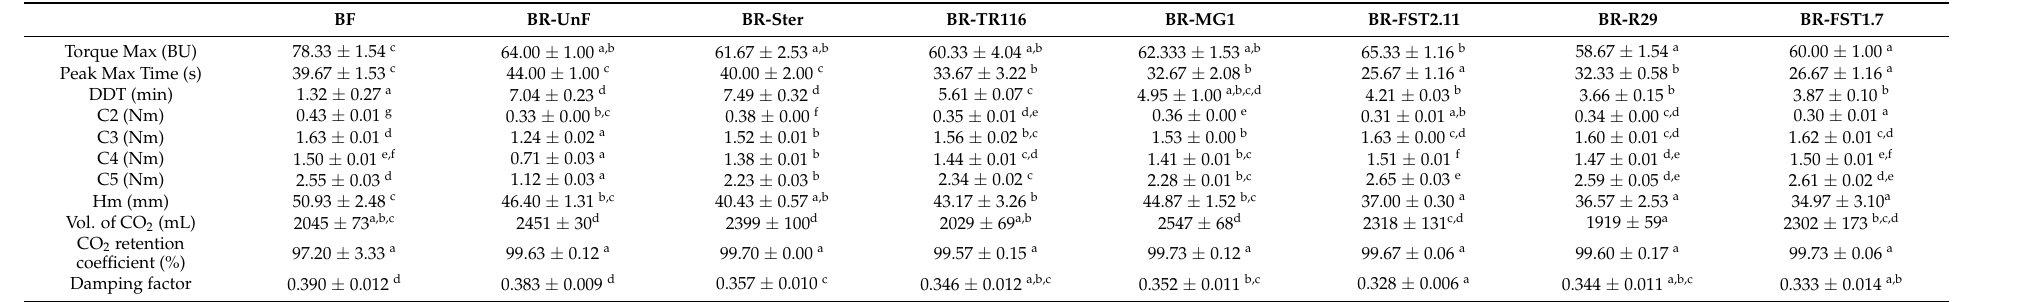
Table 4. Dough characteristics with BR inclusion. BF, BR-UnF, and BR-Ster represent control recipes using baker’s flour, 5% unfermented barley rootlet inclusion, and 5% sterilised, freeze-dried barley rootlet inclusion, respectively. BR-TR116, BR-MG1, BR-FST2.11, BR-R29, and BR-FST1.7 denote recipes including fermented rootlets at a 5% addition level and fermented using L. citreum TR116, W. cibaria MG1, L. amylovorus FST2.11, L. reuteri R29, and L. plantarum FST1.7, respectively. Results are illustrated as mean values ± standard deviations. Samples in the same row that share the same subscript letter had no significant statistical differences ( p < 0.05). BF BR-UnF